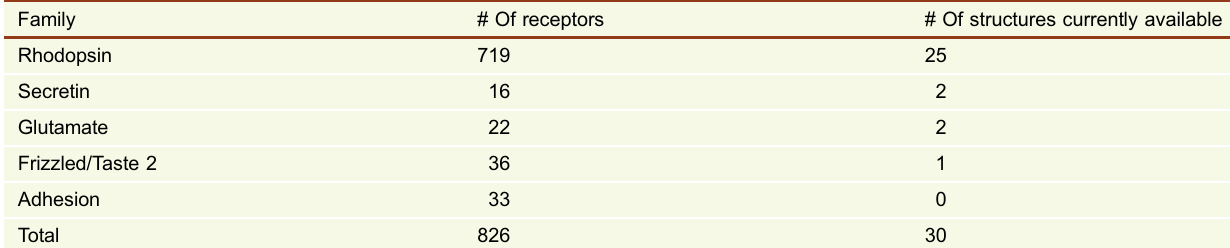
Table 1. The families of 826 GPCRs and their structures Family # Of